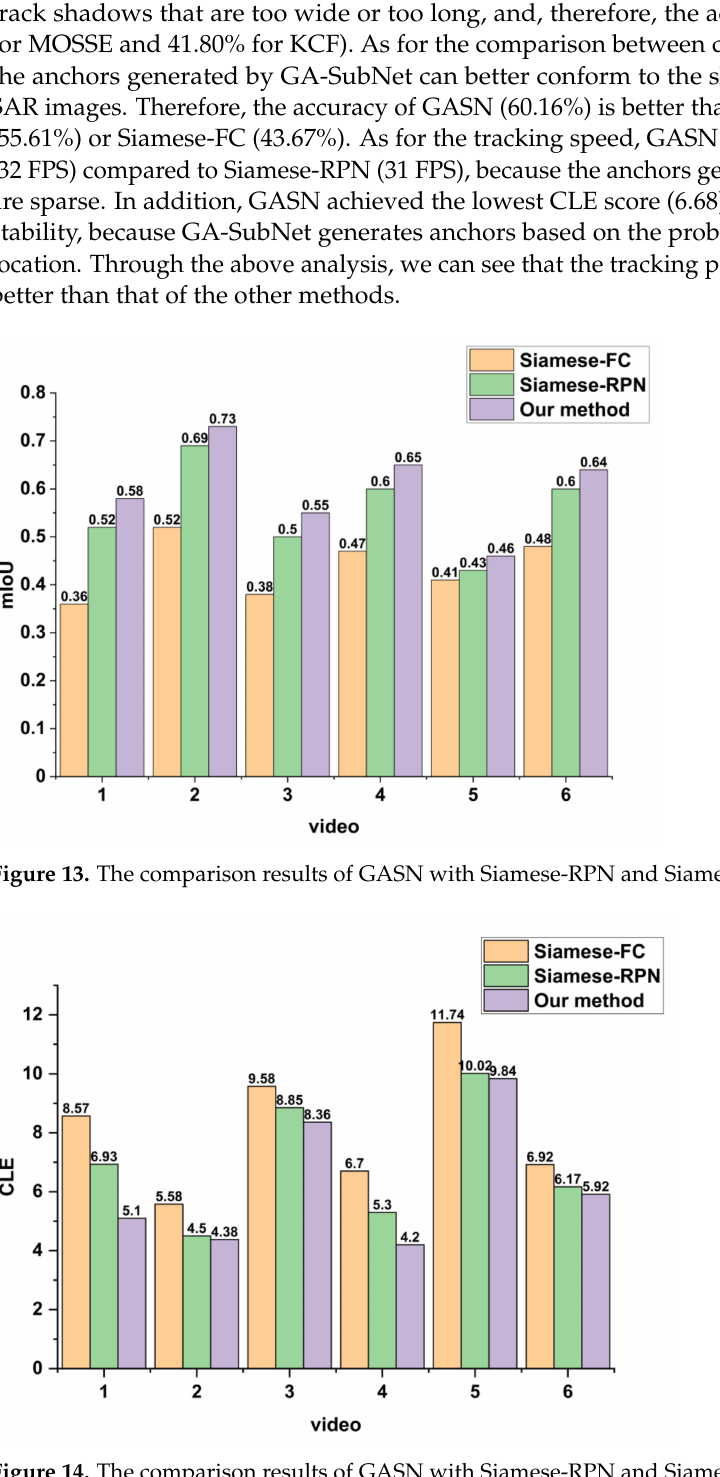
Figure 14. The comparison results of GASN with Siamese-RPN and Siamese-FC on